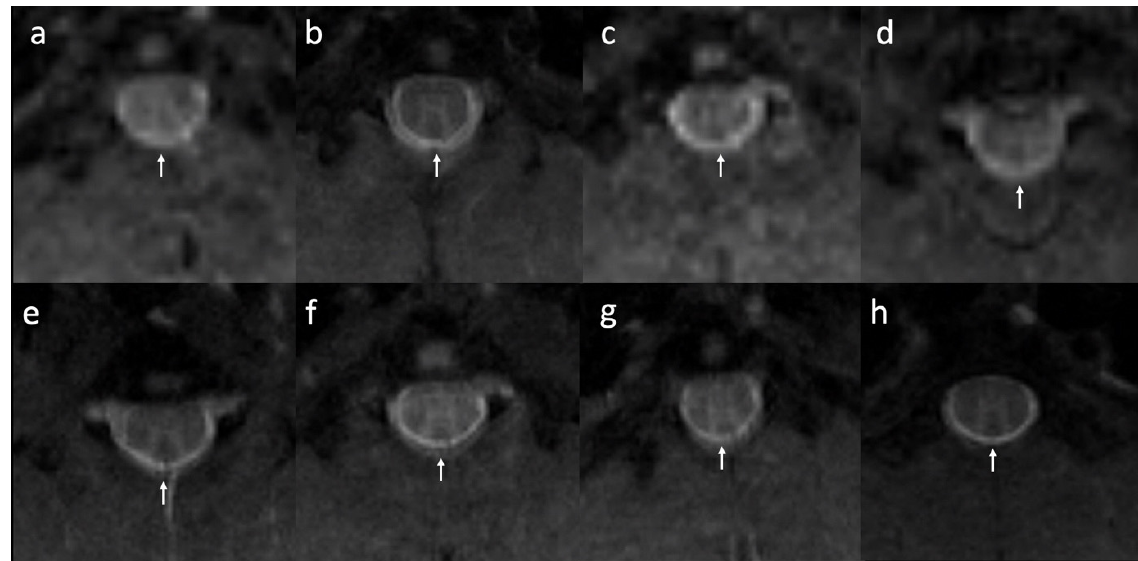
Figure 9. T2-weighted MRI slices. No post-operative shrinkage or dura mater expansion was observed along the surgical site. The thickness of the epidural fibrotic tissue was relatively thinner in the treatment group and thicker in the control group. ( a – d ) control group; ( e – h ) treatment group (white arrow: epidural fibrosis).